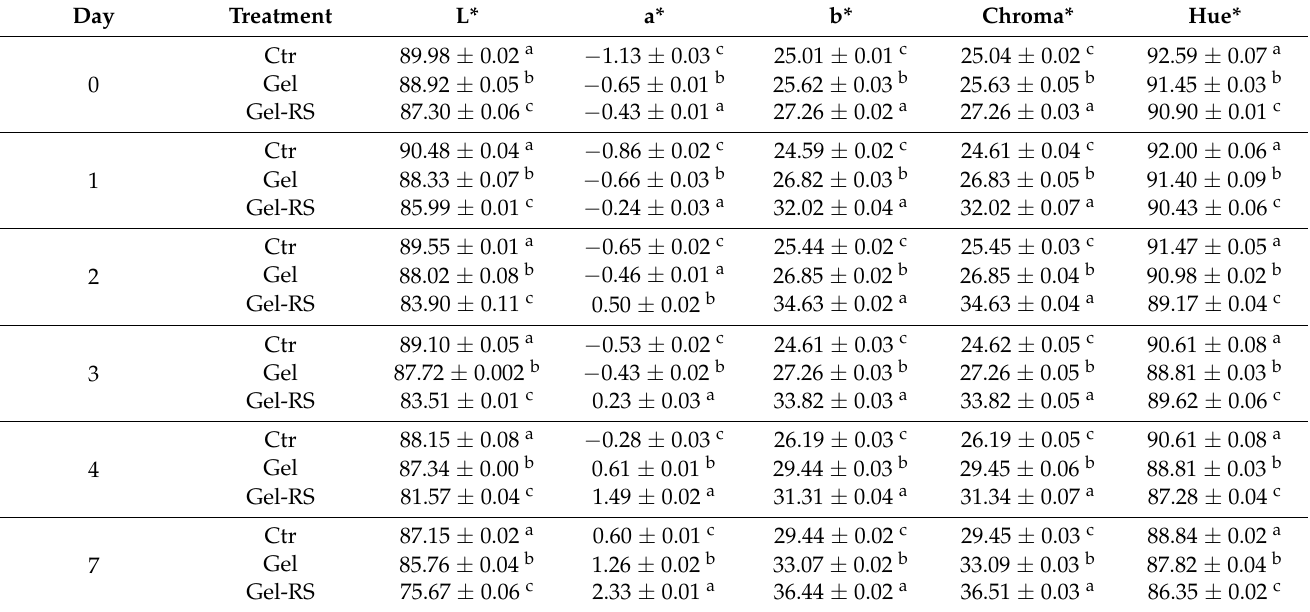
Table 1. Color parameters L*, a*, b*, Chroma* and Hue* angle of coated fresh cut zucchini samples during a 7-day storage period at 5 ◦ C. Sample analysis was in